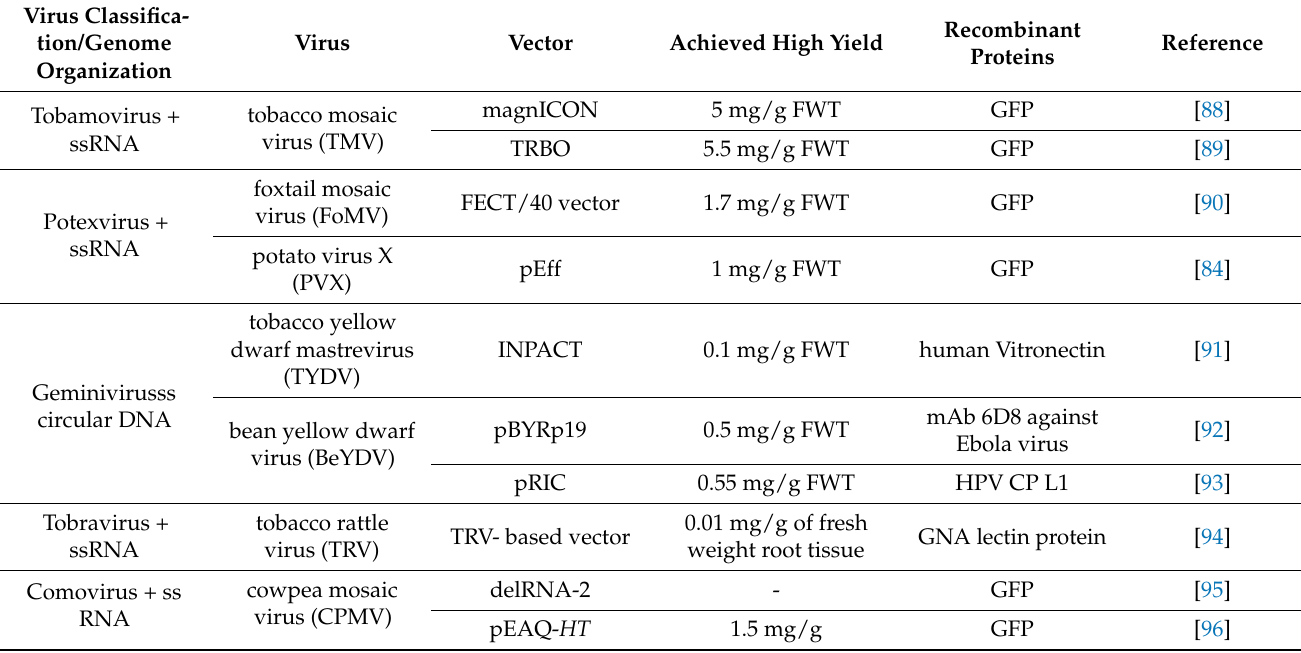
Table 1. List of some viruses used for the design of viral